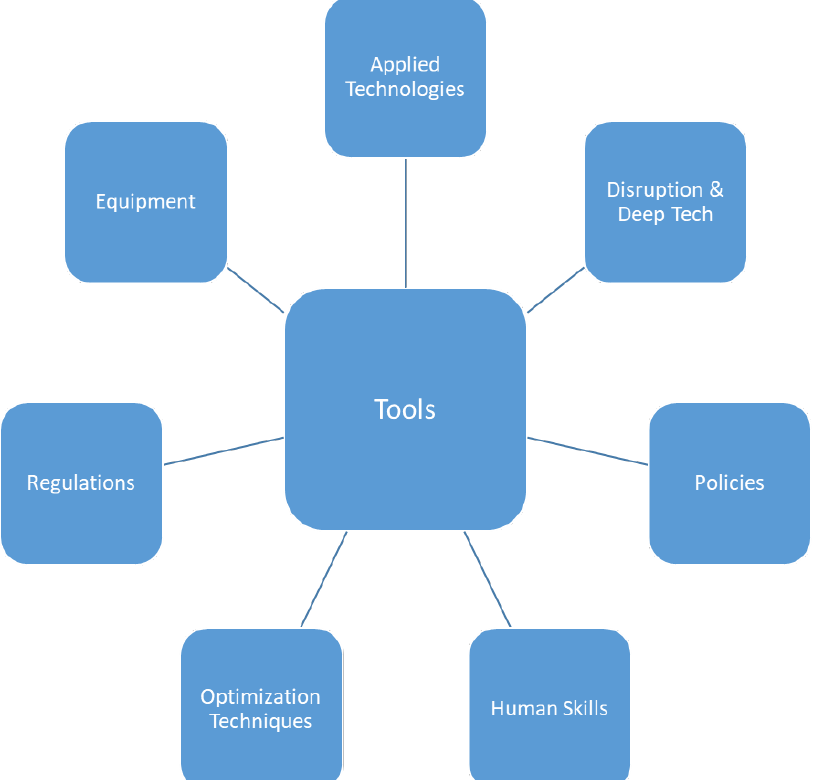
Figure 1. The problem of choosing the right combination for a successful workflow.